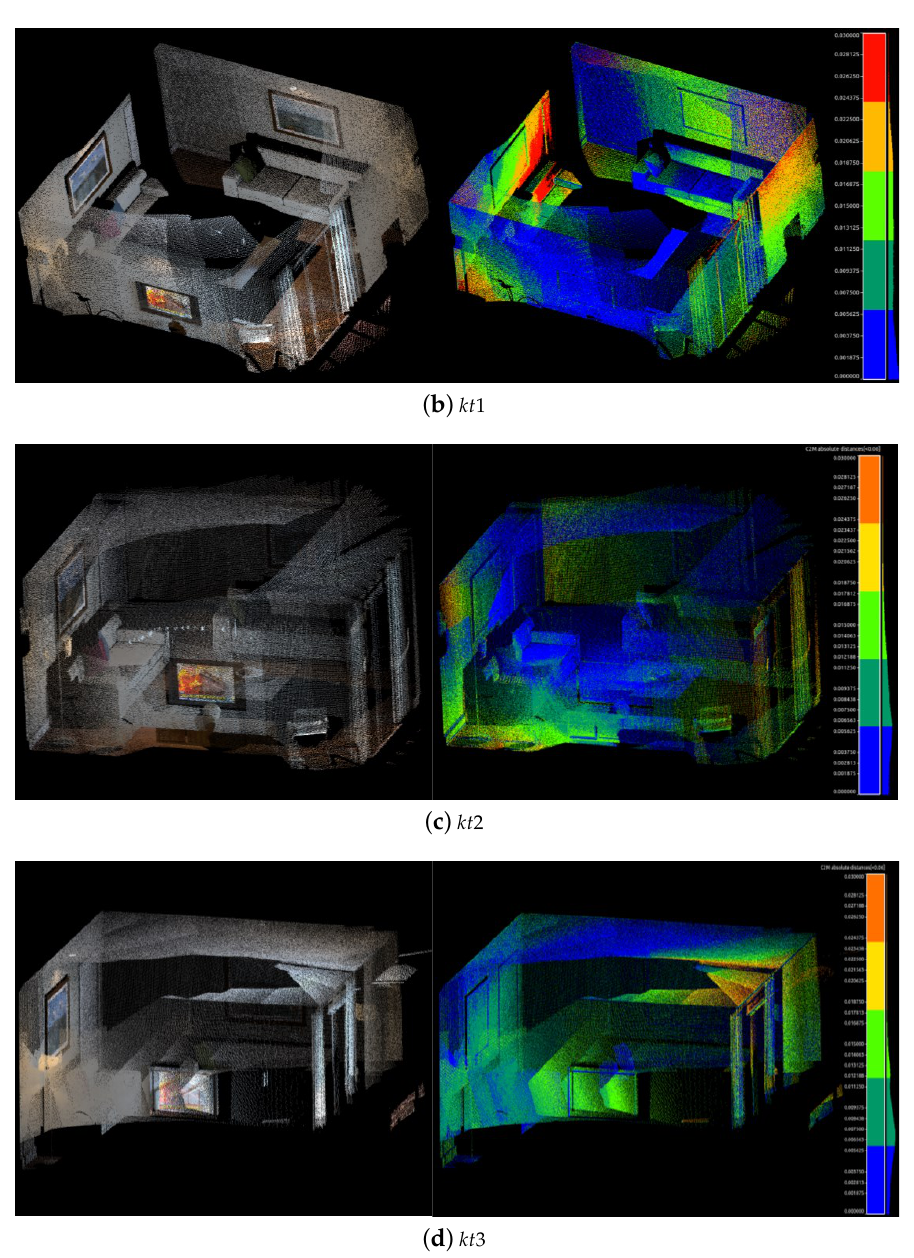
Figure 5. Reconstruction results of the ICL-NUIM dataset. The left shows the reconstructed point clouds. The right shows the error heatmap, in which the red part represents a 3 cm error and the blue part represents a 0 cm